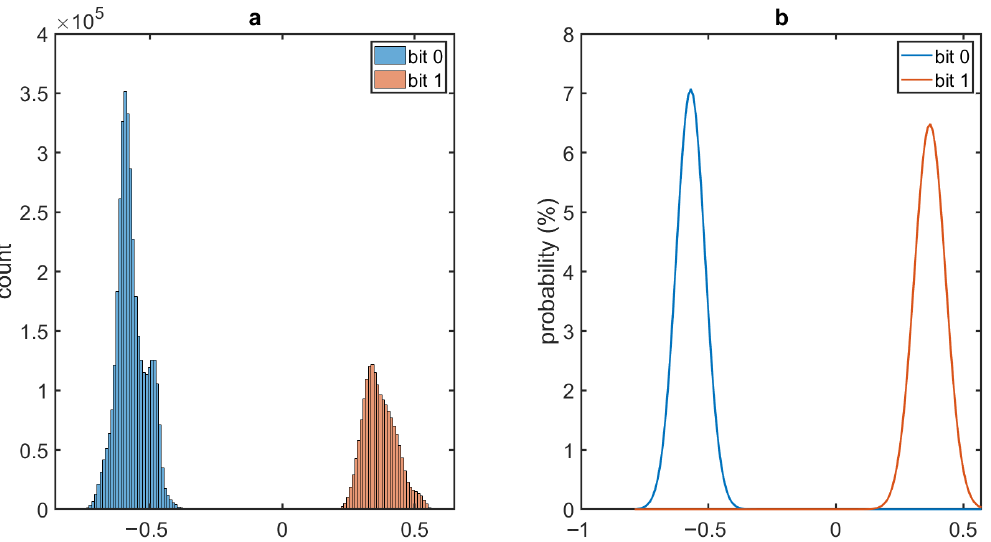
Figure 10. ( a ) Histograms of received binary signal levels showing the actual distribution for the symbols ‘0’ and ‘1’. ( b ) Gaussian fit for probability density functions ( P 0 and P 1 ) of the received signal levels for the two